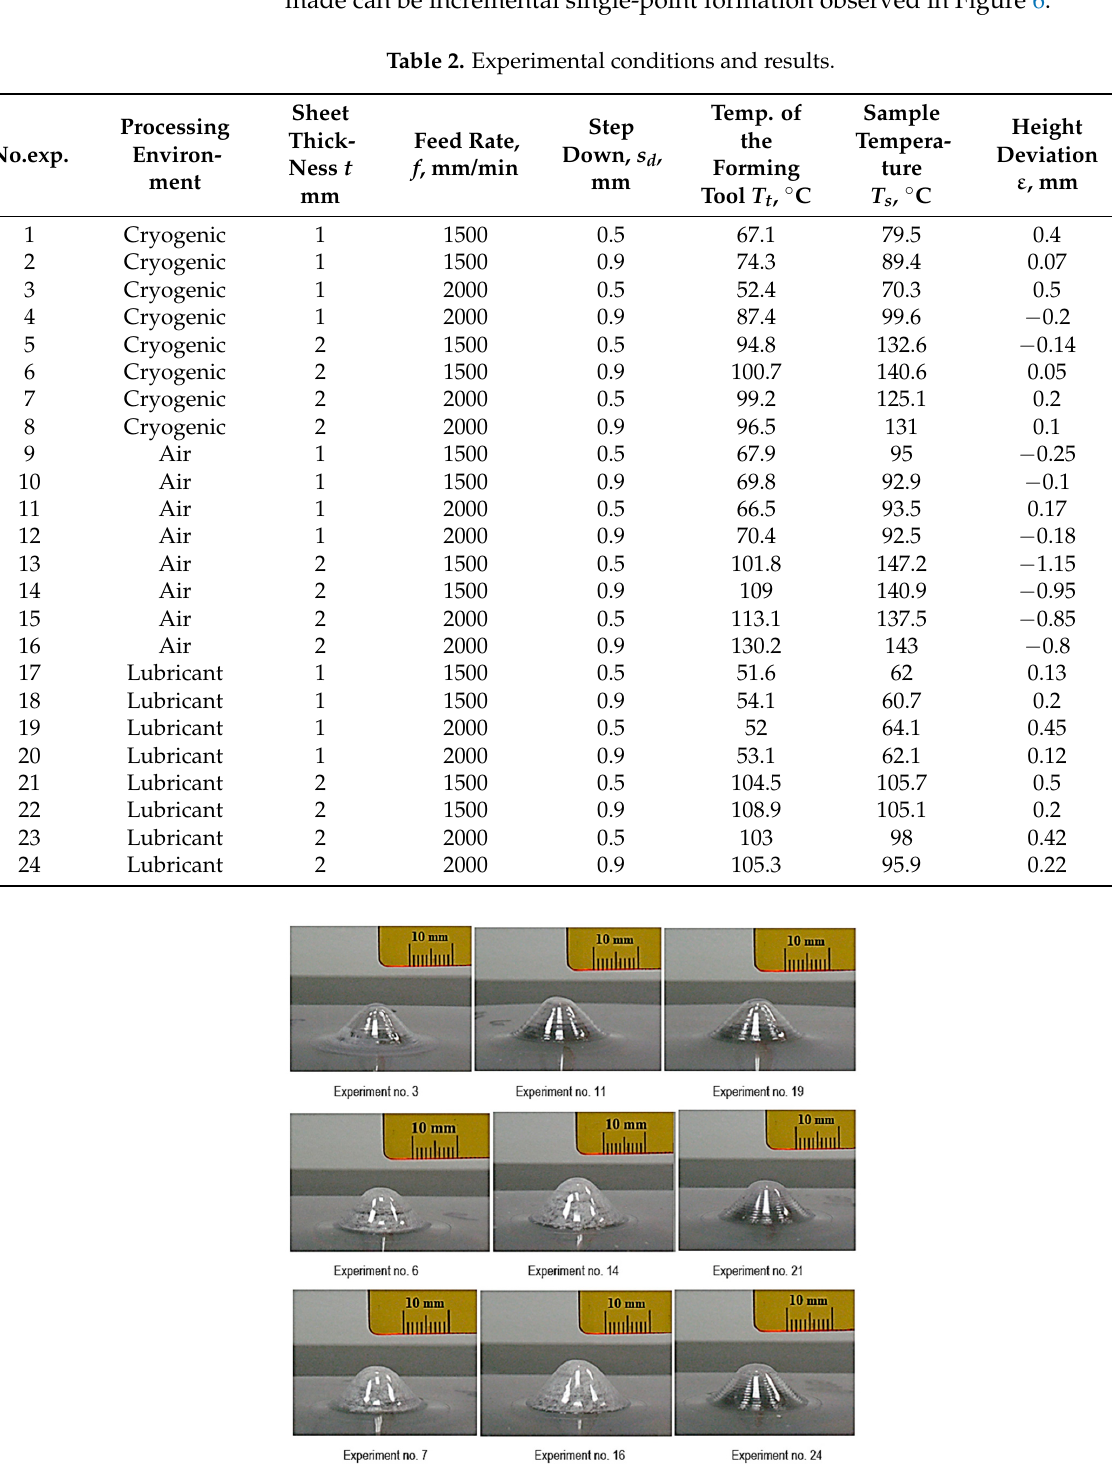
Figure 6. Examples of conical frustums obtained by single-point incremental